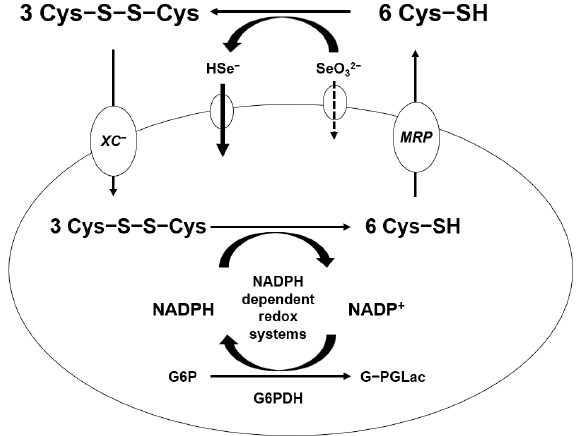
Figure 3. Absorption mechanism of high dose of sodium selenite.